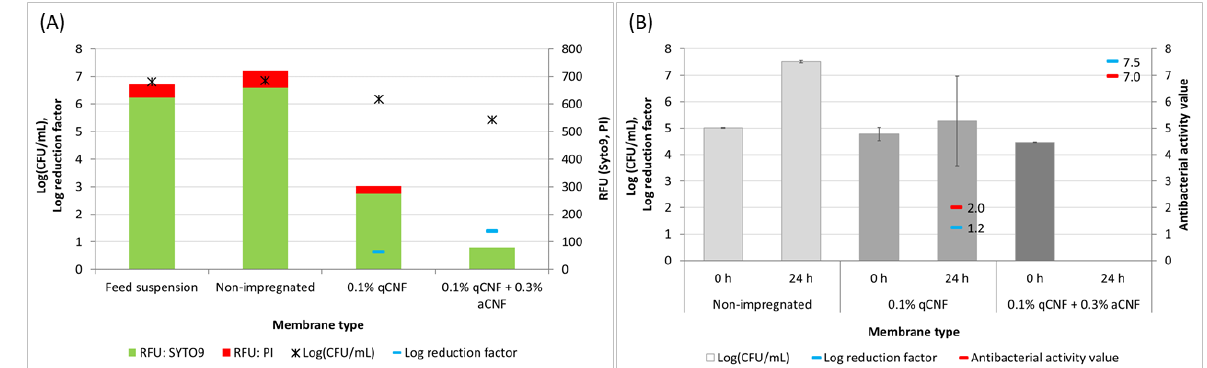
Figure 2. Viability of Gram-negative Escherichia coli (EXB-V127) after ( A ) acute exposure during the filtration experiment, and ( B ) chronic exposure to selected individual membranes, namely, non-impregnated membrane (control) and membranes impregnated with 50 mL of 0.1% quaternised cellulose nanofibrils (qCNF) with or without the addition of 0.3% amino-hydrophobised CNF (aCNF). ( A ) The viability after acute exposure was determined by the SYTO9 and propidium iodide (PI) fluorescence viability staining with a LIVE/DEAD BacLight Bacterial Viability Kit (L7012, Invitrogen, Molecular probes) and the plate count method. The fluorescence was measured spectroscopically by using an excitation wavelength centred at 475 nm. The stacked bar graph shows the average relative fluorescence units (RFU) of the green (Syto9, at 505 nm) and red (PI, at 617 nm) emissions after subtracting the signal of the dye solution without cells (blank) from the stained bacterial cell suspensions. ( B ) The chronic 24-h contact exposure to selected individual membranes was determined by the absorption method (ISO 20743:2013, [31]). The results are presented as the average values of log (CFU/mL) (±SD) and log reduction factor (primary x axis). In addition, the antibacterial activity value, calculated as the difference between the growth value on the non-impregnated fibrous membrane and the qCNF/aCNF impregnated membrane specimens, is also given (secondary x axis).